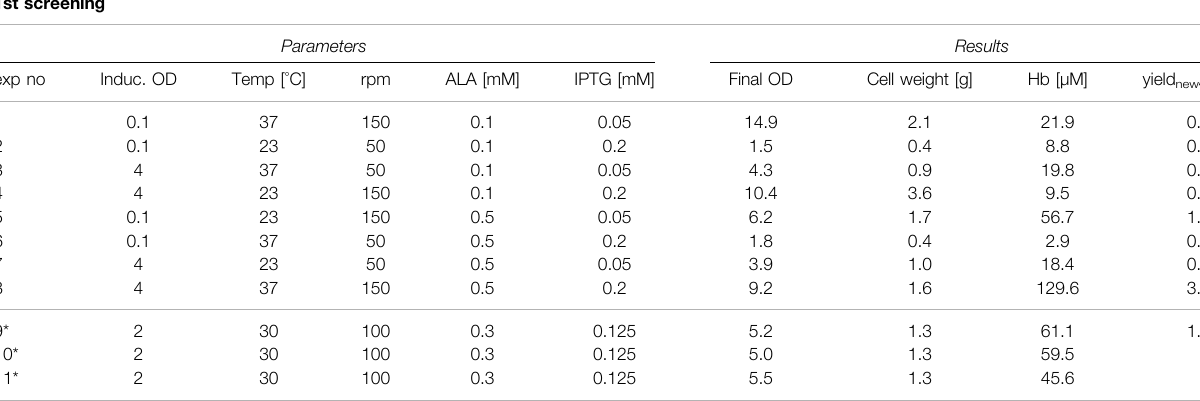
TABLE 1 | DoE screening of fl ask culture parameters for Hb